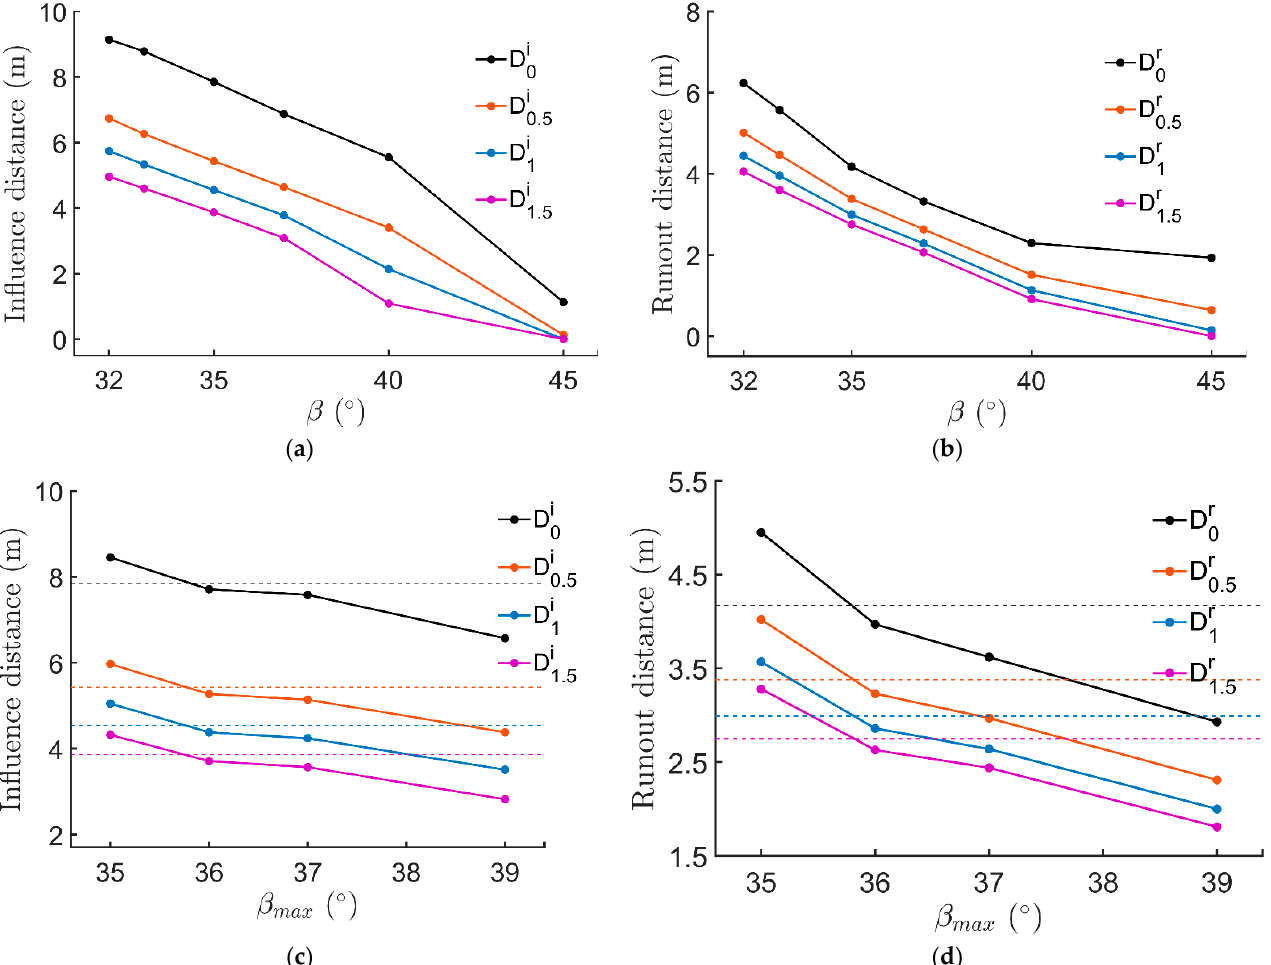
Figure 13. Variations in influence distance and runout with different friction angles: ( a ) different influence distances in uniform slopes; ( b ) different runout distances in uniform slopes; ( c ) different influence distances in layered slopes; ( d ) different runout distances in layered slopes.